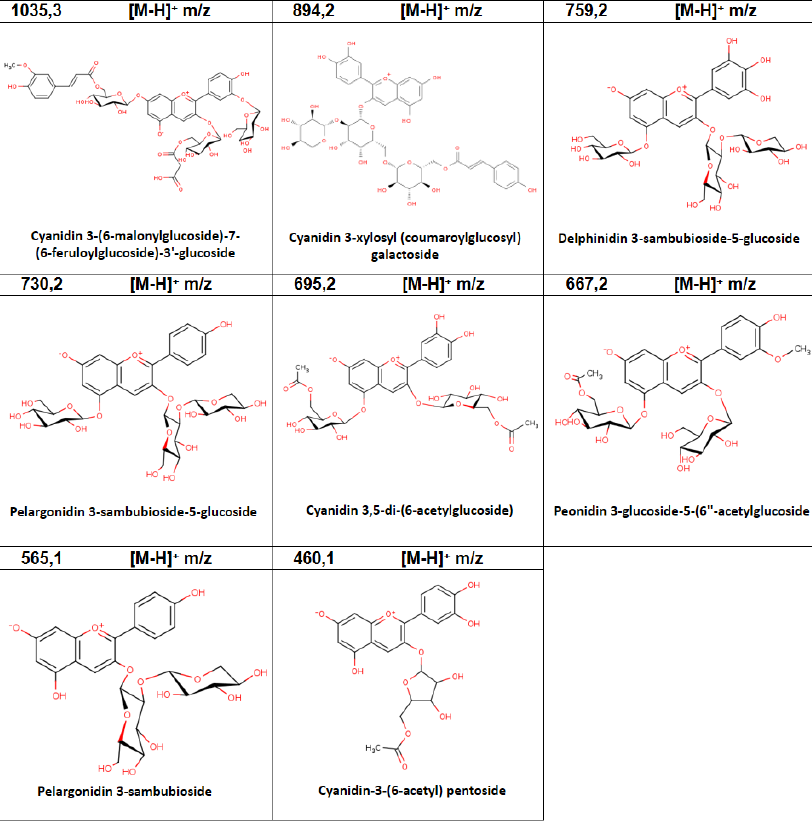
Figure 2. Chemical structure of the main anthocyanins identified by LC ‐ MS/MS analysis for the aqueous extracts of fruit of A. chilensis .